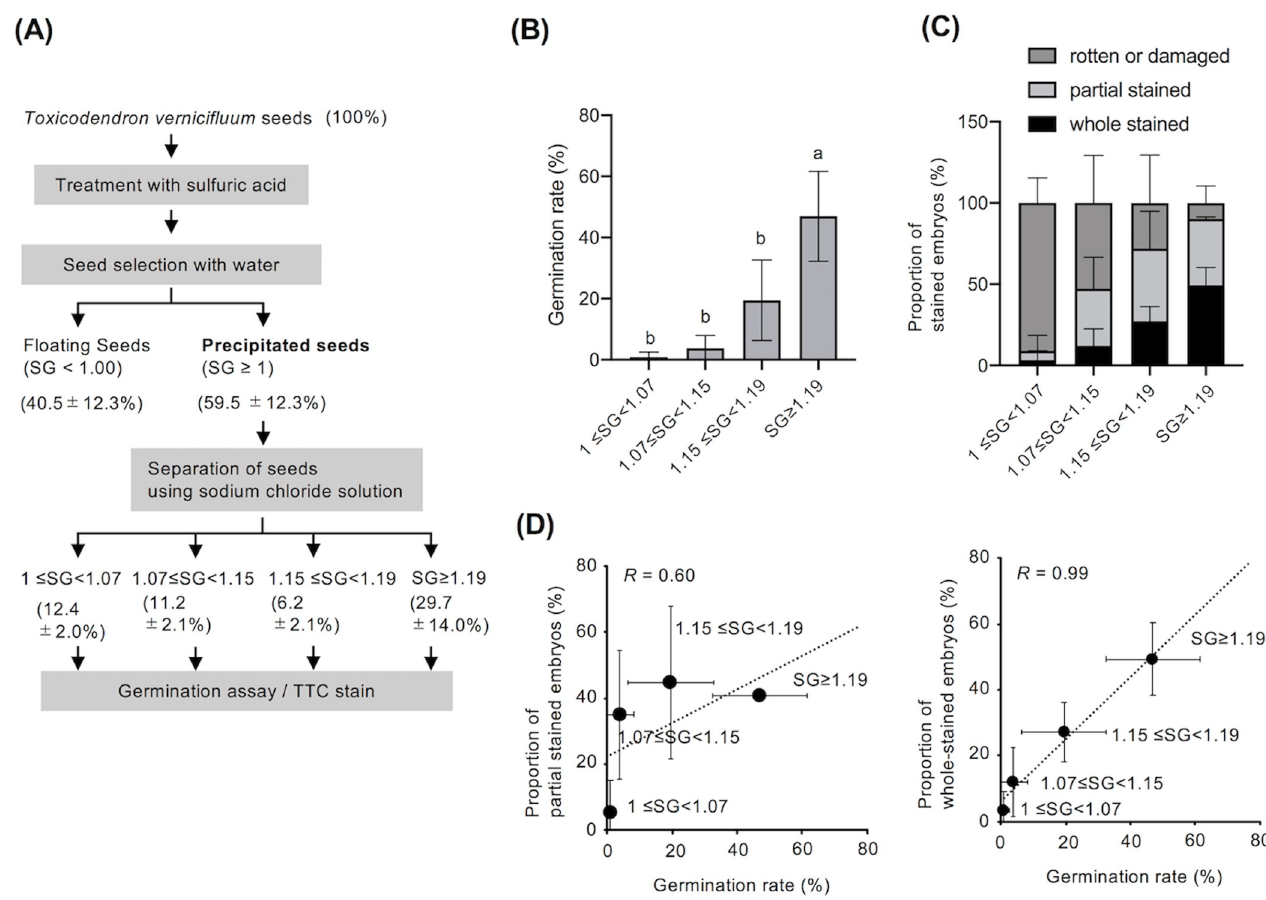
Fig 4. Relationship between seed specific gravity (SG) and germination ability. (A) Proportion of seeds with different SGs. Seeds were separated using sodium chloride solutions of different SGs, and the proportions (%) were calculated based on the initial number of seeds. (B) Effect of seed SG on germination. After cold pretreatment for 3 weeks, seeds were incubated at 20˚C, and germinated seeds were counted 60 days after the start of incubation. Averages and standard deviations are shown for seeds collected in 2018, 2019, and 2020 ( n = 3). Datasets were analyzed using one-way ANOVA with Tukey’s multiple comparisons test with a significance level of 5% ( P < 0.05). (C) Relationship between the SG of seeds and the proportion of seeds with mature embryos. TTC- stained embryos are classified into three types: whole-stained embryos, partially stained embryos, and rotten or damaged embryos. The total number of embryos investigated was normalized to 100, and the proportion of embryos of each type was calculated. (D) Correlation between the percentage of partially stained or whole-stained embryos in seeds and the germination rate. R indicates the calculated Pearson’s correlation coefficient. Averages and standard deviations are shown for seeds collected in 2018, 2019, and 2020 ( n = 3) (C,